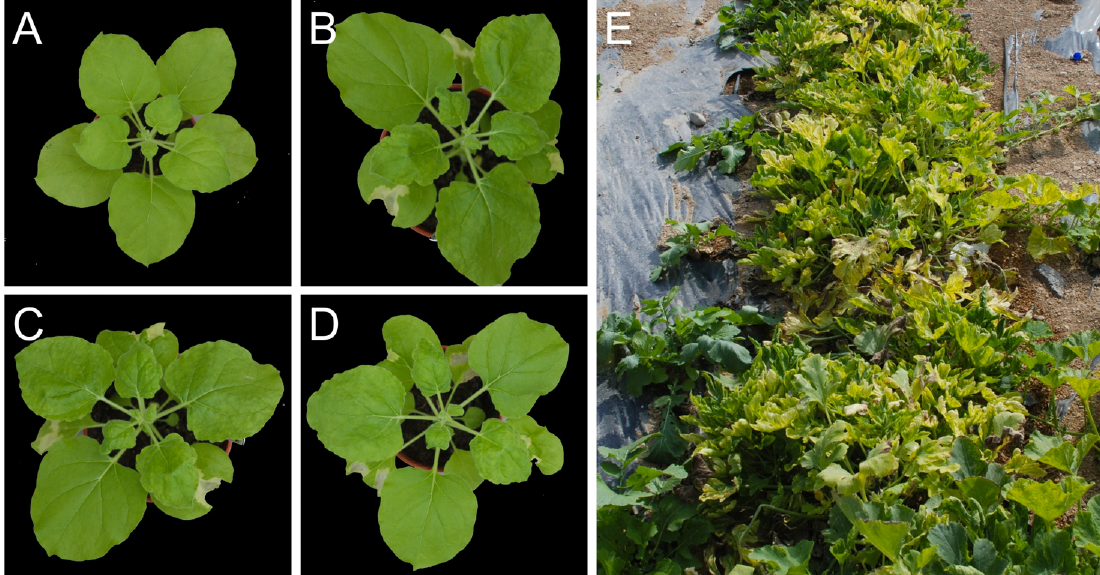
Figure 4. Symptoms of plants infected with WmCSV. A non-inoculated healthy N. benthamiana plant ( A ); N. benthamiana plants inoculated with the clones of WmCSV ( B–D ) and squash plants in the field infected with WmCSV ( E